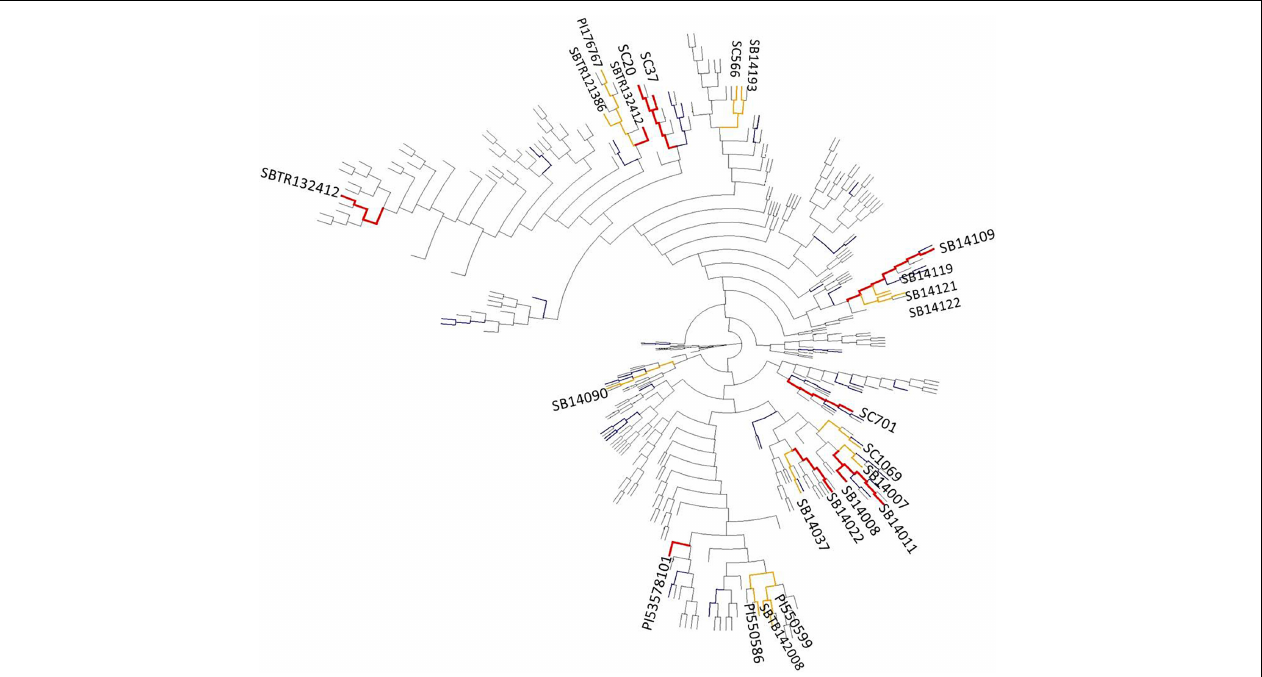
FIGURE 3 | Phylogram constructed using the neighbor-joining method, showing the genetic relatedness in the diversity set ( n = 330) and among lines with superior reproductive cold tolerance (colored bars). Genotypes ranking among the top 5% of performers for more than one cold tolerance trait ( Table 4 ) are highlighted in red, while genotypes that are among the top 5% for a single trait ( Figure 2 ) are highlighted in orange. Genotypes with a mean panicle harvest index (PHI) in the upper 5–25% quantile in the pooled stress environments are colored in blue, unless they were previously assigned to one of the two previous groups.